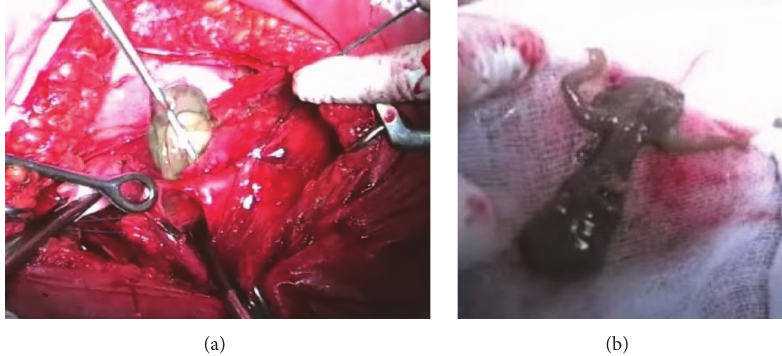
Figure 3: (a) The stage of fetal removal from the bladder cavity. (b) The dead fetus with signs of autolysis.